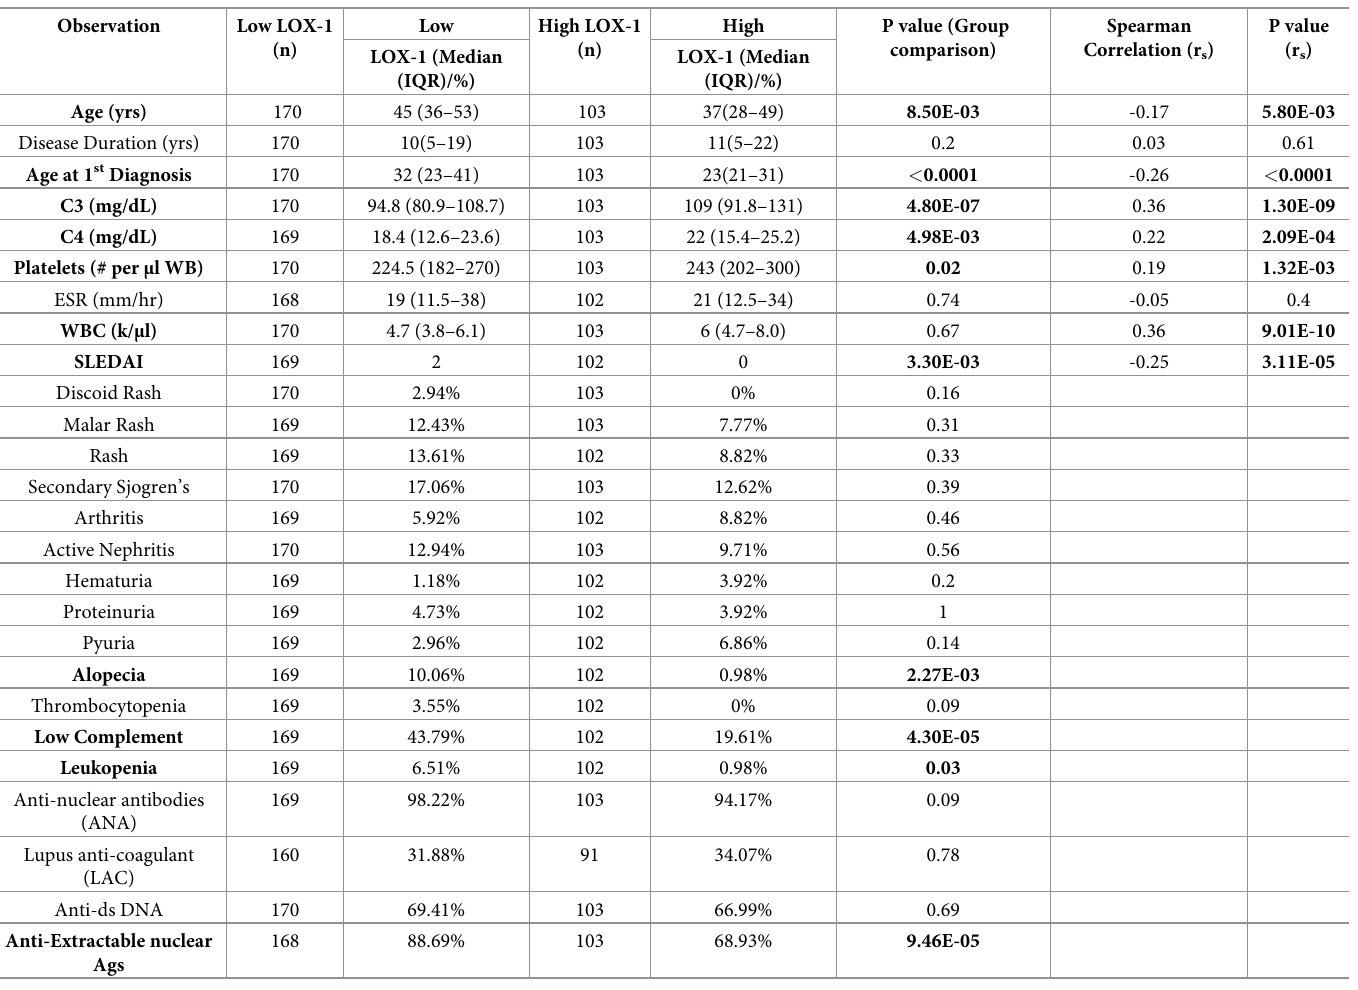
Represented p-values for comparison between groups. Spearman correlations (r s ) and their p- value calculated for association of groups containing continuous variables with corresponding sLOX-1 levels. C3 = Complement 3, C4 = Complement 4, ESR = Erythrocyte sedimentation rate, WBC = White blood cells, SLEDAI = SLE Disease Activity